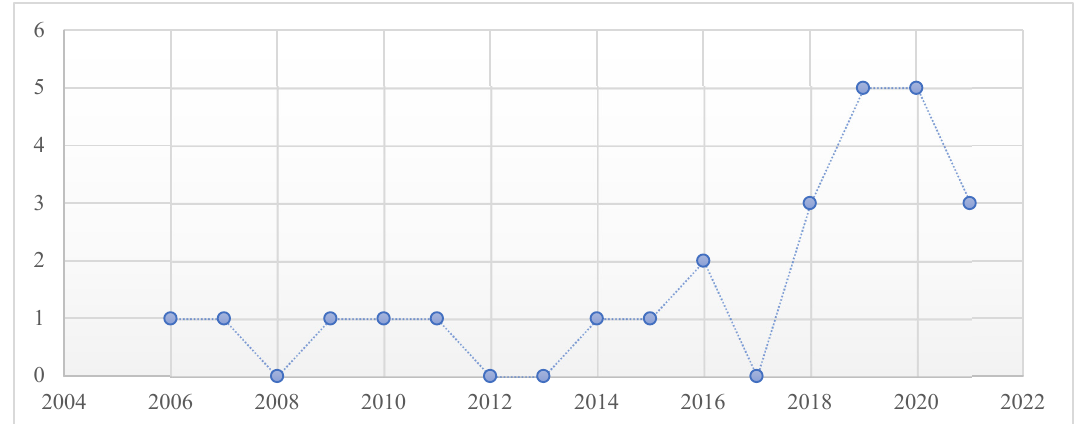
Figure 2. Number of reviewed papers selected by year published.